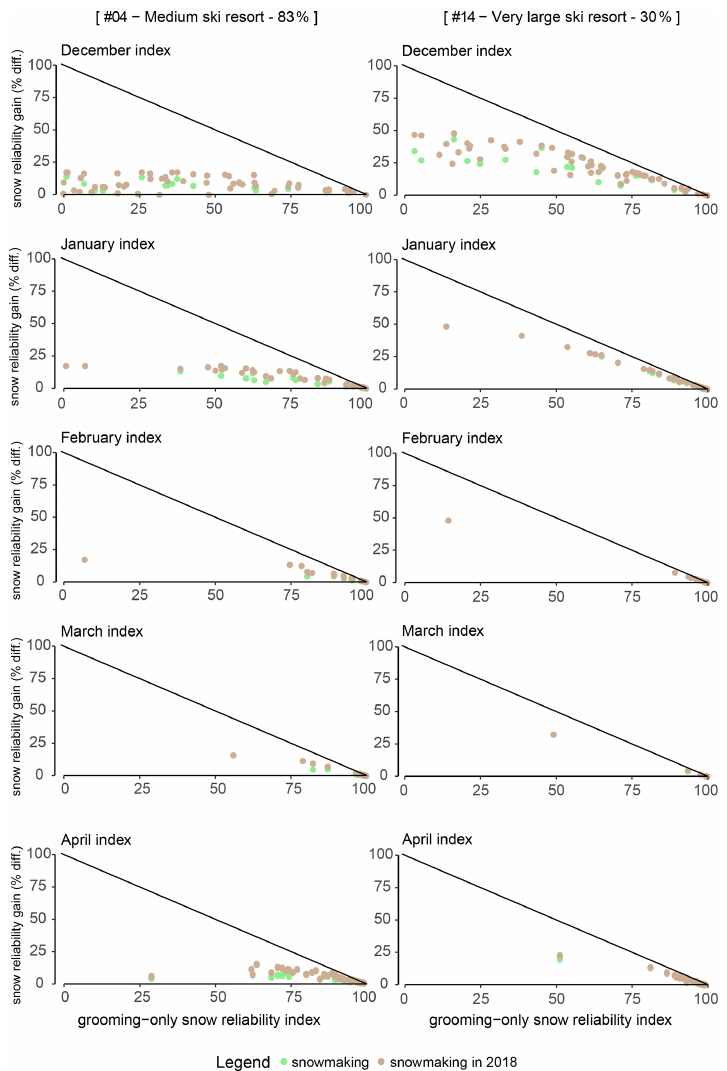
Figure 7. Relationship between the monthly (December, January, February, March and April, from top to bottom) snow cover reliability difference ( y axis) between configurations with snowmaking and the snow cover reliability with grooming only (no snowmaking, x axis), for two contrasting very large ski resorts and for the time period from 1961 to 2019, on the left with below-average snowmaking coverage and on the right with above-average snowmaking